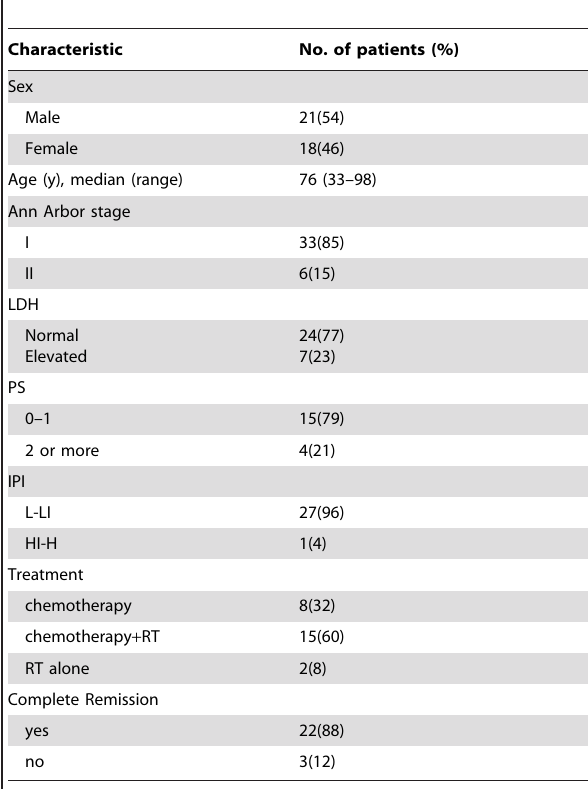
these patients achieved complete remission following alternative chemotherapy. Salvage treatments for the 7 relapsed patients were R-MFP (methotrexate, fluorouracil, low dose cisplatin, and rituximab), R-THP-COP (cyclophosphamide, vincristine, pred- nisolone, pirarubicin, and rituximab), R-MTX (methotrexate and rituximab), and CHASER (cyclophosphamide, high dose cytar- abine, dexamethasone, etoposide, and rituximab) plus radiation. At the time of reporting, 16 patients were disease- free and 3 patients had died of the disease. Comparison of the Clinicopathological Characteristics of Localized Nasal/Paranasal DLBCL and Localized Nodal DLBCL The clinicopathological characteristics of nasal/paranasal DLBCL and localized nodal DLBCL are summarized in Table 5. Nasal/paranasal DLBCL patients showed good prognosis. The slight difference in the overall survival between these patients and patients with localized nodal DLBCL was not significant ( p= 0.30) (Fig. 4). Moreover, analysis using the x 2-test revealed a significant difference between the 2 groups with regard to age distribution and immunophenotype. Localized nasal/paranasal DLBCL patients were more likely to be more than 60 years old than localized nodal DLBCL patients ( p= 0.018). In addition, localized nasal/paranasal DLBCL patients showed significantly higher positivity for MUM1 than localized nodal DLBCL patients according to Choi’s algorithm ( p= 0.00023, x 2-test).